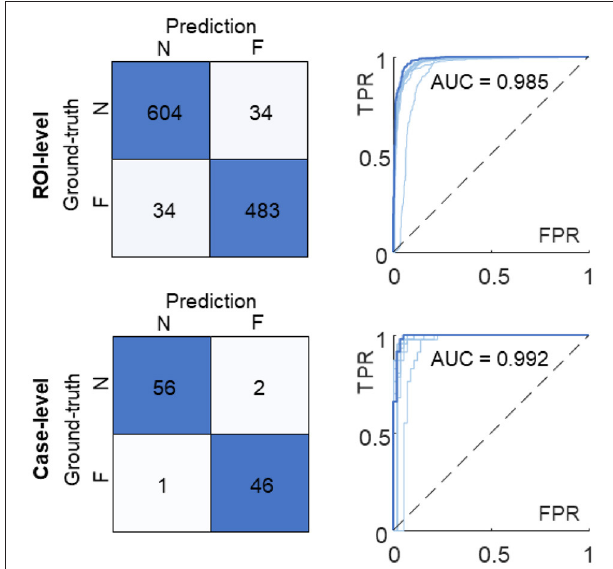
FIGURE 7 | Confusion matrices and ROC curves of the multi-model ensemble. The ROI-level and case-level results are reported at the top and bottom, respectively. The ROC curve and AUC value of the 10-model ensemble (in dark blue) are compared with the ones of individual sub-models (in light blue). N, non-failure; F, failure; ROC, receiver operating characteristic; AUC, area under ROC curve; FPR, false positive rate; TPR, true positive rate.